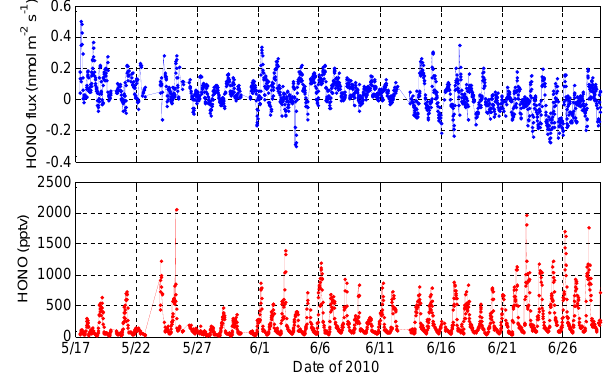
Figure 2. Time series of HONO flux (top) and HONO concentration (bottom) measured during 2 Fig. 2. Time series of HONO flux (top) and HONO concentration CalNex 2010. 3 (bottom) measured during CalNex 4 The diurnal variations of chemical species and meteorological parameters are shown in 5 Figure 3. On average, HONO fluxes appeared to be upward during the day with a maximum of 6 ~0.1 nmol m -2 s -1 observed in the morning and were close to zero (-0.007±0.017 nmol m -2 s -1 ) at 7 night. The observed daytime HONO fluxes are reasonable considering the moderate levels of 8 reactive nitrogen species existing in San Joaquin Valley. Highest HONO fluxes were observed 9 when winds were from northwest, where downtown Bakersfield is located. 10 11